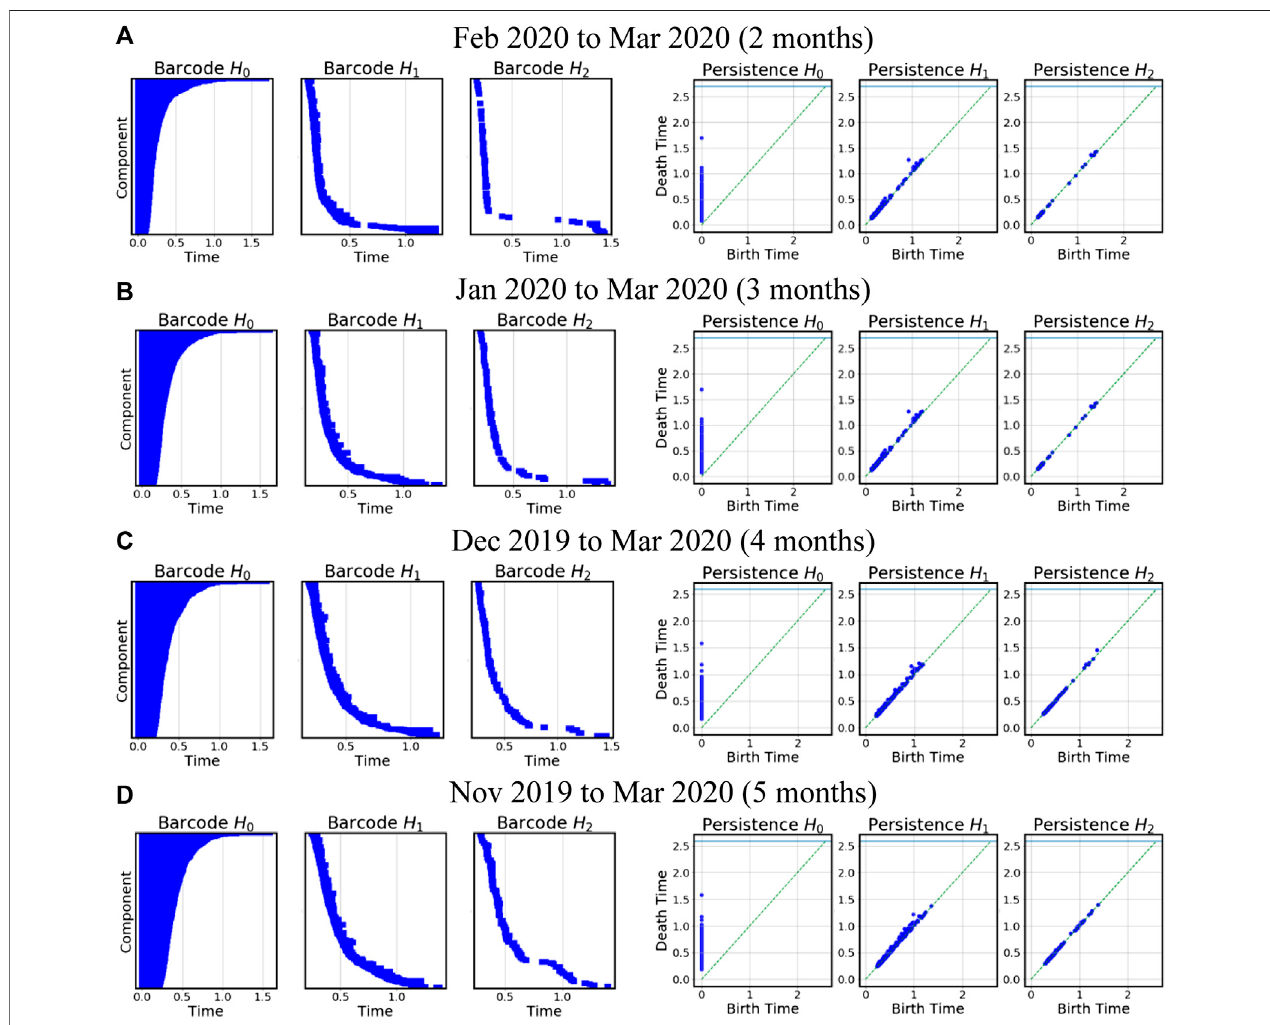
FIGURE12| Thebarcodes andpersistence diagramscoveringthepandemicCOVID-19 crashinMarch2020.The fi rstcolumnisatwo-monthwindow result,and the subsequent columns correspond to 3, 4, 5, and 6-months time windows, respectively.